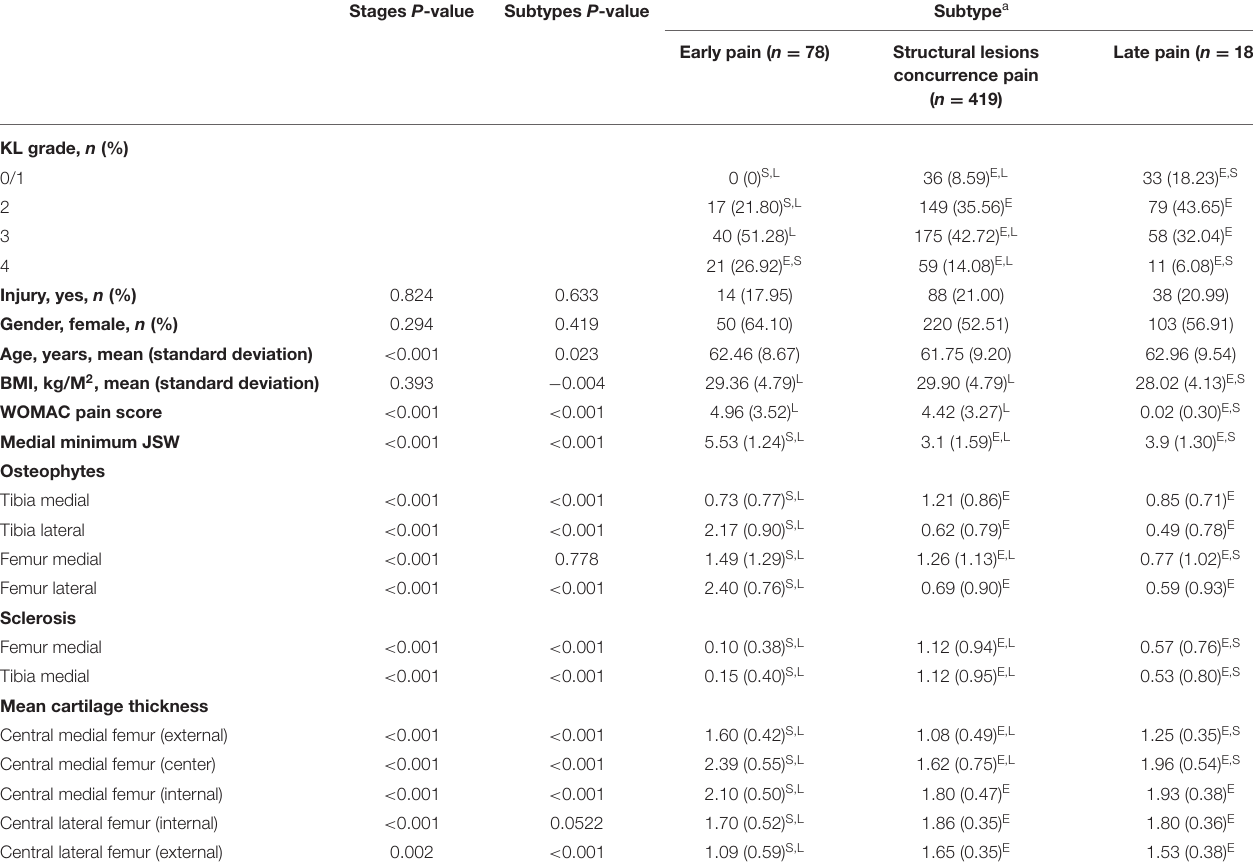
TABLE 2 | Baseline demographics and risk factors for three subtypes and differences between the measurements of all biomarkers used for subtype